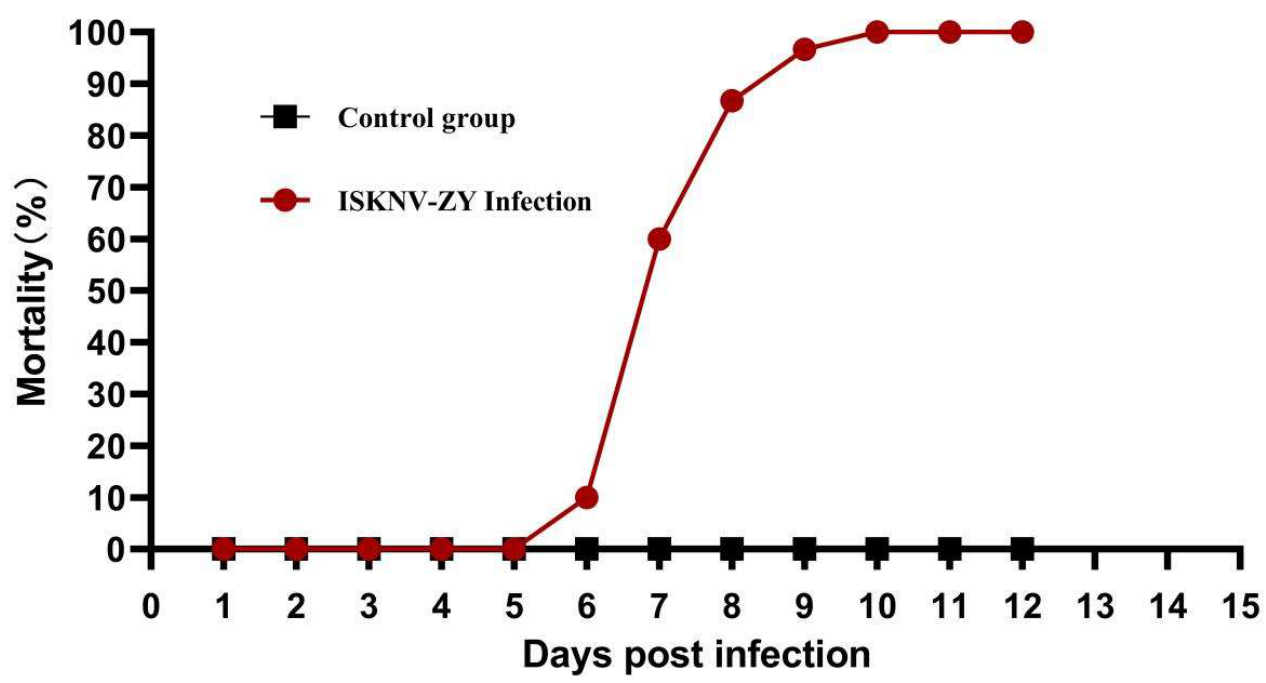
Figure 5. Pathogenicity of infectious spleen and kidney necrosis virus (ISKNV)-ZY in largemouth bass. Cumulative mortality of largemouth bass after challenge with ISKNV-ZY was recorded until day 12 post-infection.